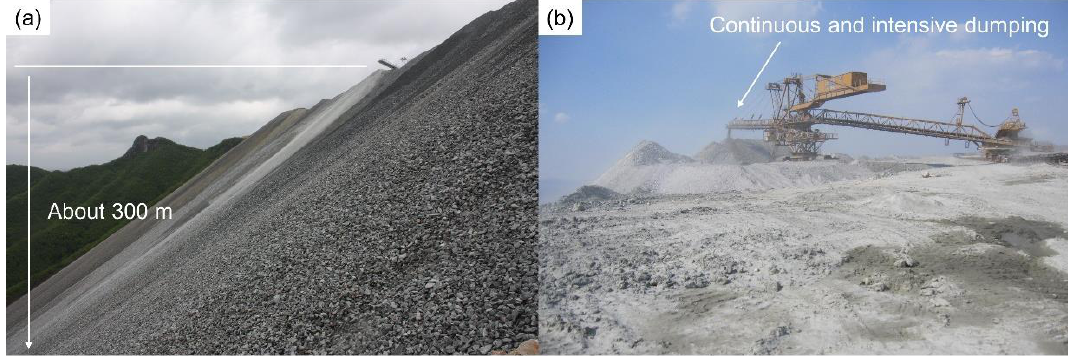
Figure 6. Dumping: ( a ) slope topography; ( b ) continuous and intensive dumping.